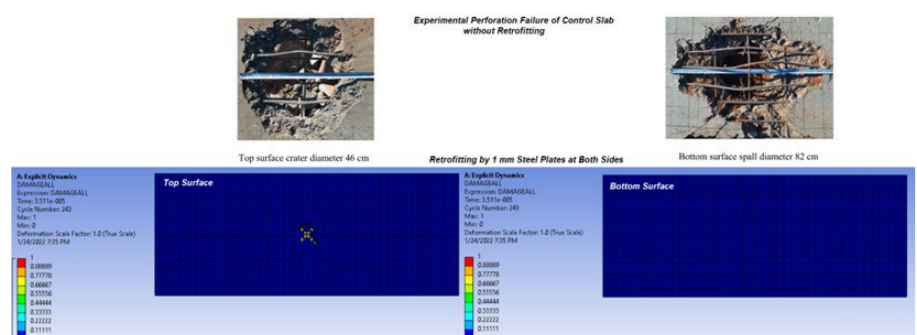
Figure 15 – Comparison between mode of failure of experimental non-retrofitted NRC-2 Slab and retrofitted NRC-2 by 1 mm steel skin plates at top & bottom surfaces